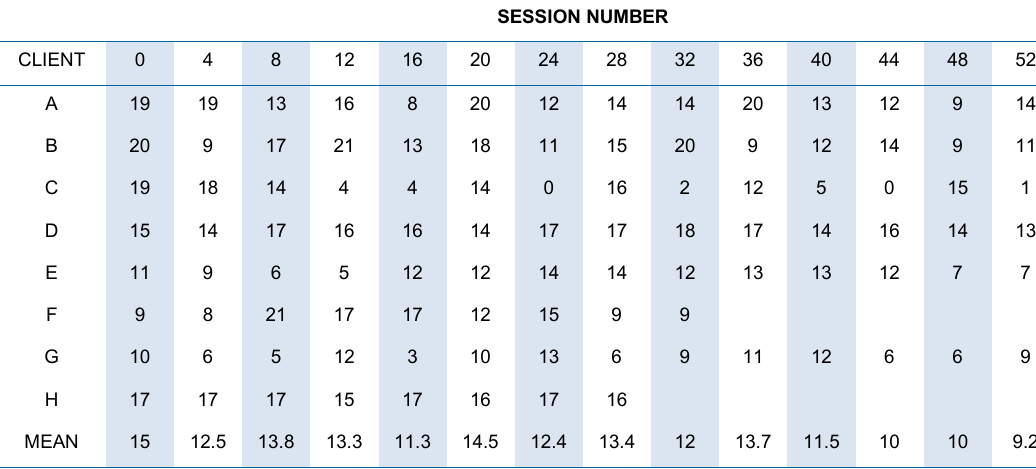
Table 6: Mean GAD-7 score: 8 long-term